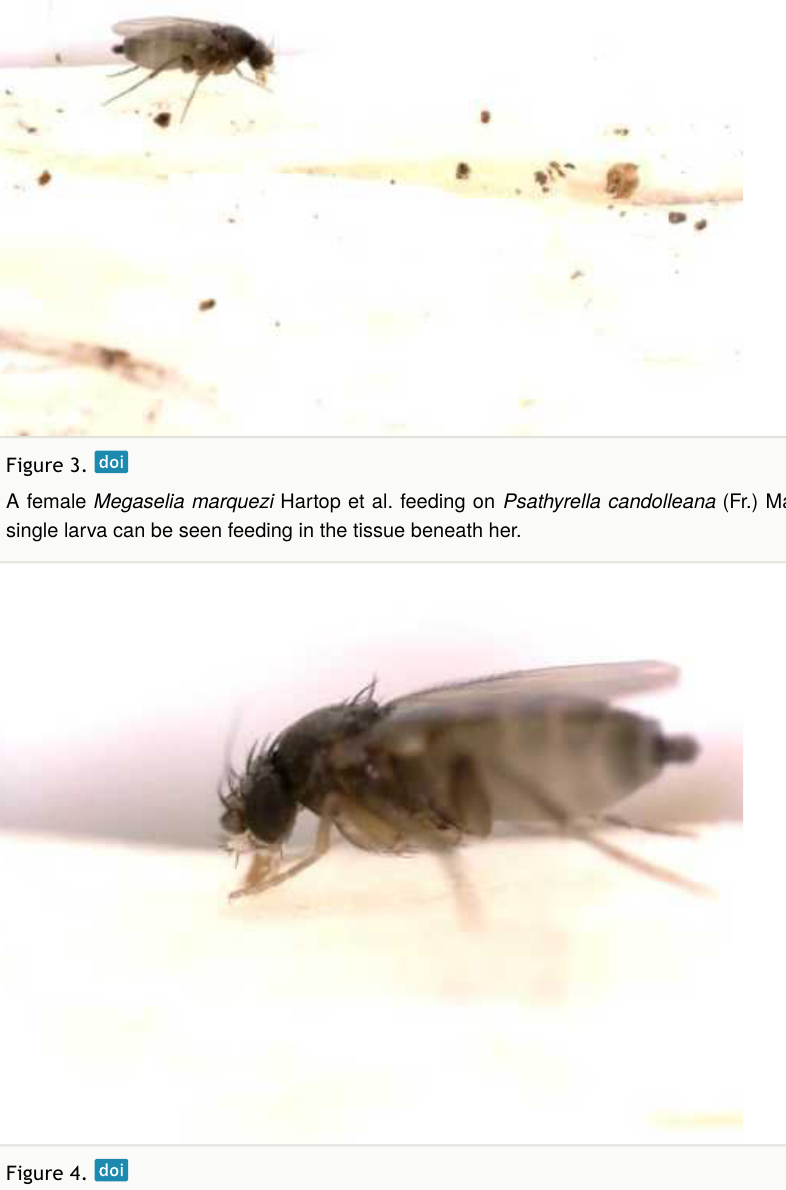
Figure 4. A close-up of a female Megaselia marquezi Hartop et al. feeding on Psathyrella candolleana (Fr.)